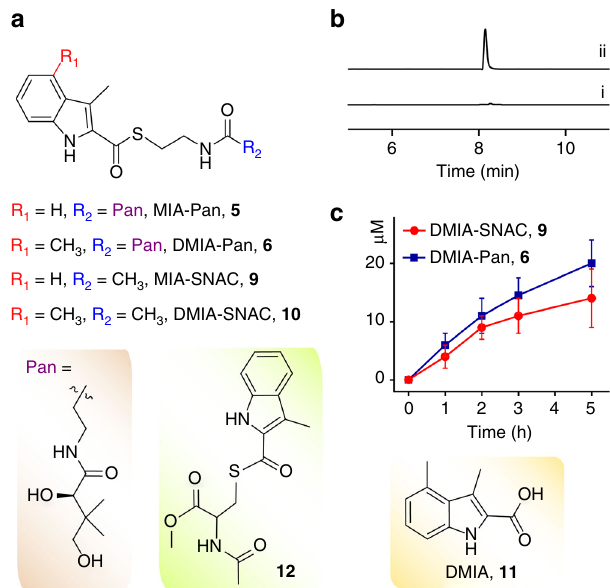
Fig. 4 Probing NosN reaction by using substrate analogues. a NosN methylates two MIA-based thioester ( 5 and 9 ) to produce the corresponding indole C4 methylated products ( 6 and 10 ). b Extracted ion chromatograms (EICs) of [M+H] + = 450.2 (corresponding to DMIA-Pan, 6 ) for (i) control reaction with the supernatant of boiled NosN, and (ii)